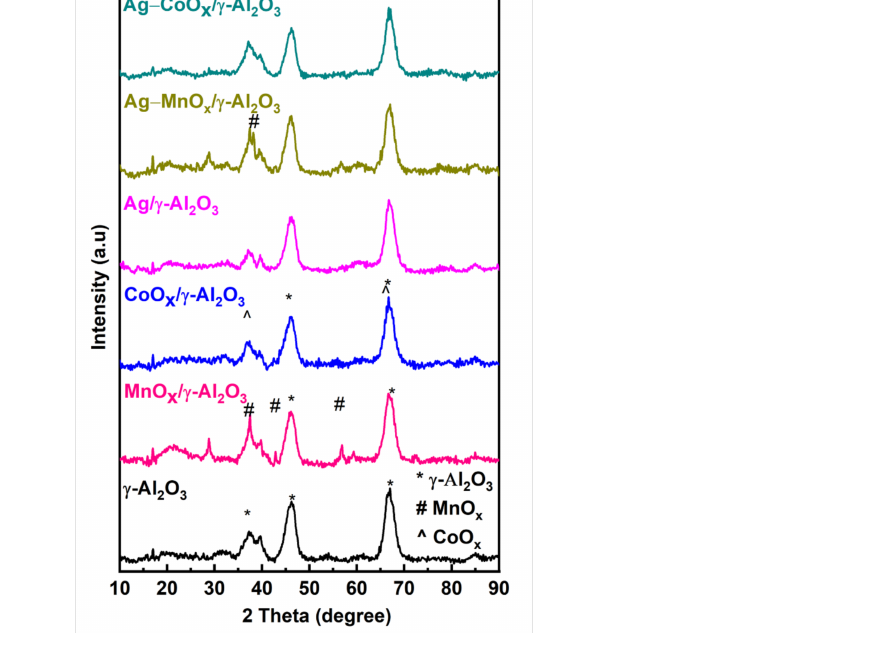
Figure 1. XRD patterns of the bare and metal oxide modified γ -Al 2 O 3 ; * γ -Al 2 O 3 , # MnO x , ˆ CoO x